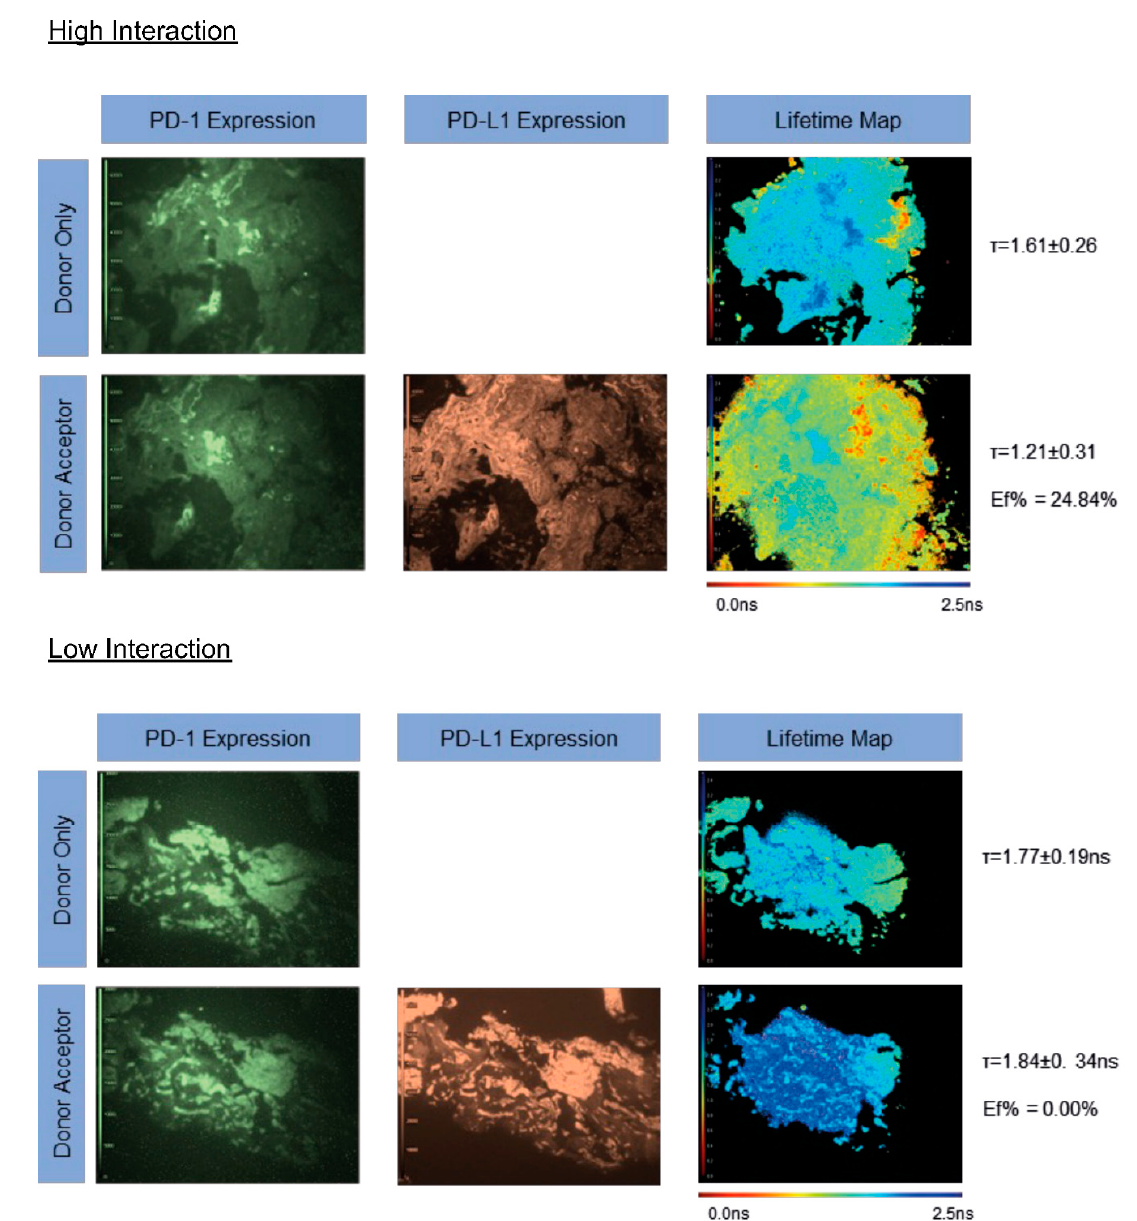
Figure 3. iFRET quantifies high and low PD-1/PD-L1 interaction states in lung metastases, detecting inter- and intratumoral heterogeneity. Representative FLIM images demonstrating high and low PD-1/PD-L1interaction states. Top panel: greyscale images indicate PD-1 or PD-L1 expression in donor-only or donor-acceptor tissue slices for one patient. No difference is observed between PD-1 expression between the donor-only and donor-acceptor slides. The lifetime map indicates the mean lifetime per pixel of an image. The donor-only lifetime (1.61 ns ± 0.26 ns) is represented by blue/green in the pseudo-color scale. In the donor-acceptor slide, the lifetime of the donor is reduced to 1.21 ± 0.31 ns, yielding a FRET efficiency of 24.84%. This is indicative of a high PD-1/PD-L1 interaction state. Bottom panel: here, a good expression of PD-1 and PD-L1 are observed and no significant differences in expression profiles are seen between the top and bottom panels. However, the donor-only lifetime here is 1.77 ± 0.19 ns, which fails to reduce in the presence of the acceptor, giving a FRET efficiency of 0.00%. This indicates that PD-1/PD-L1 are not interactive in this sample, despite the presence of both receptor and ligand. Critically, in both examples, high tissue level coincidence is observed between the donor-only and donor-acceptor slices, meaning that donor lifetime changes are due to the presence of the acceptor chromophore and are not reporting on intratumoral